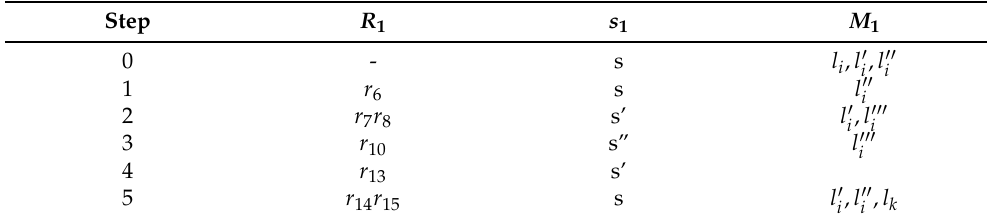
Table 6. The application of rules in R 1 , the evolution of channel states s 1 , and the rewriting of multisets M 1 in membrane 1. During the simulation of a SUB instruction l i :( SUB ( r ) , l j , l k ) with register r